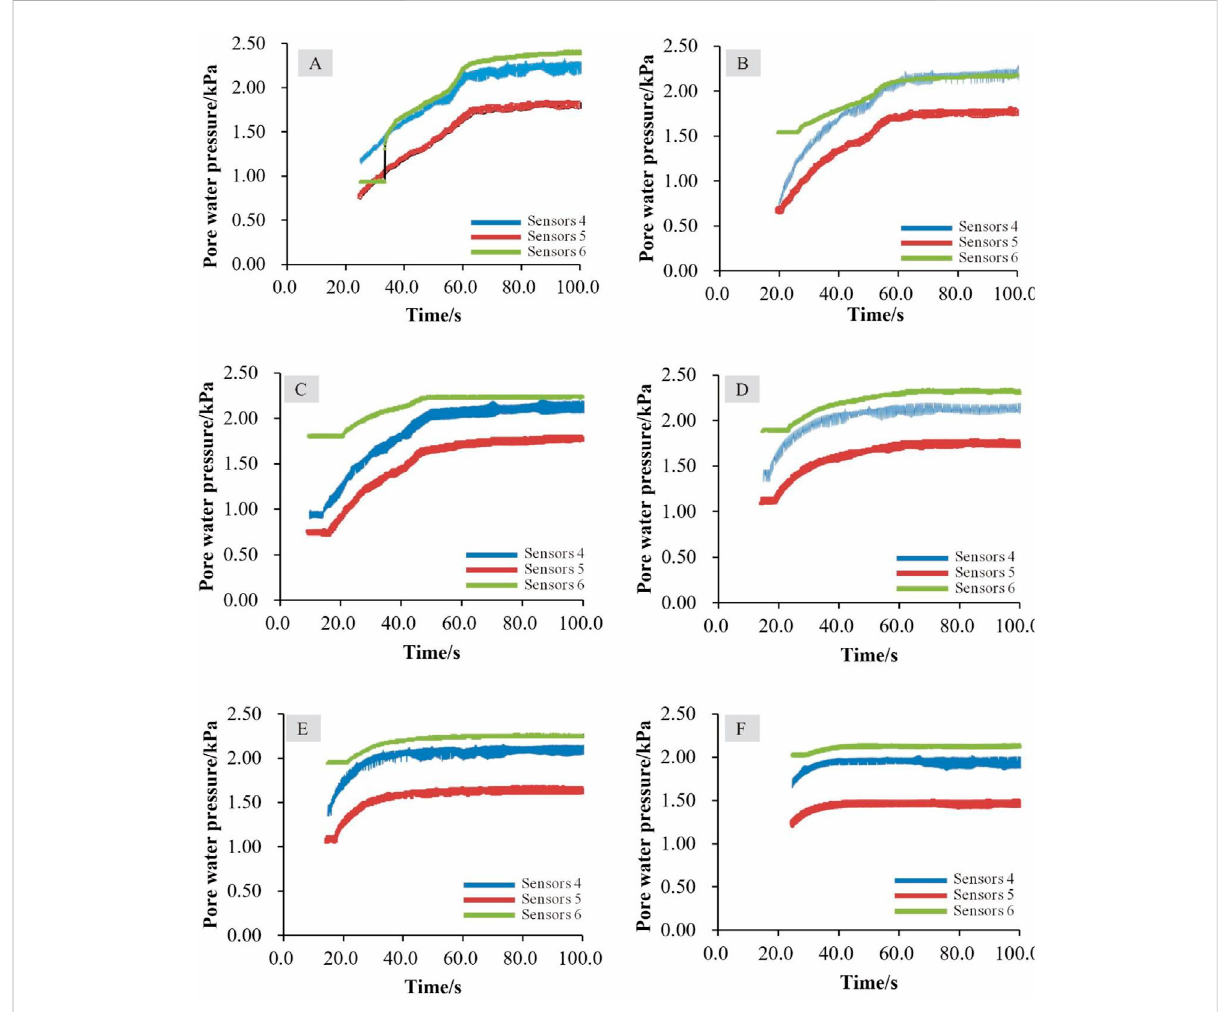
FIGURE 7 Pore-water pressure changes through the experimental process for various slope angles (A) 6 ° , (B) 9 ° , (C) 12 ° , (D) 15 ° , (E) 18 ° , and (F) 20 ° .